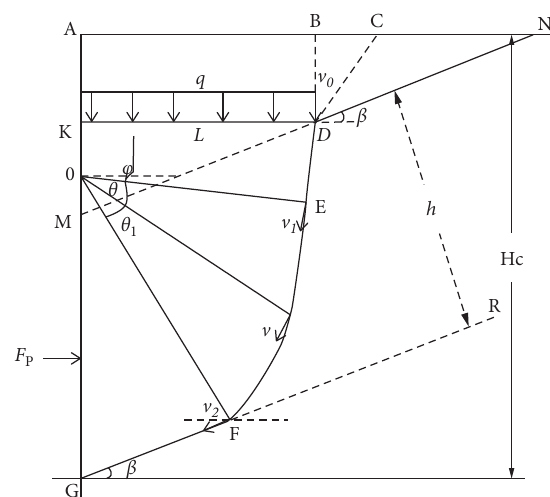
Figure 2: Analysis and calculation model of the upper bound method for rock slopes containing structural planes and karst